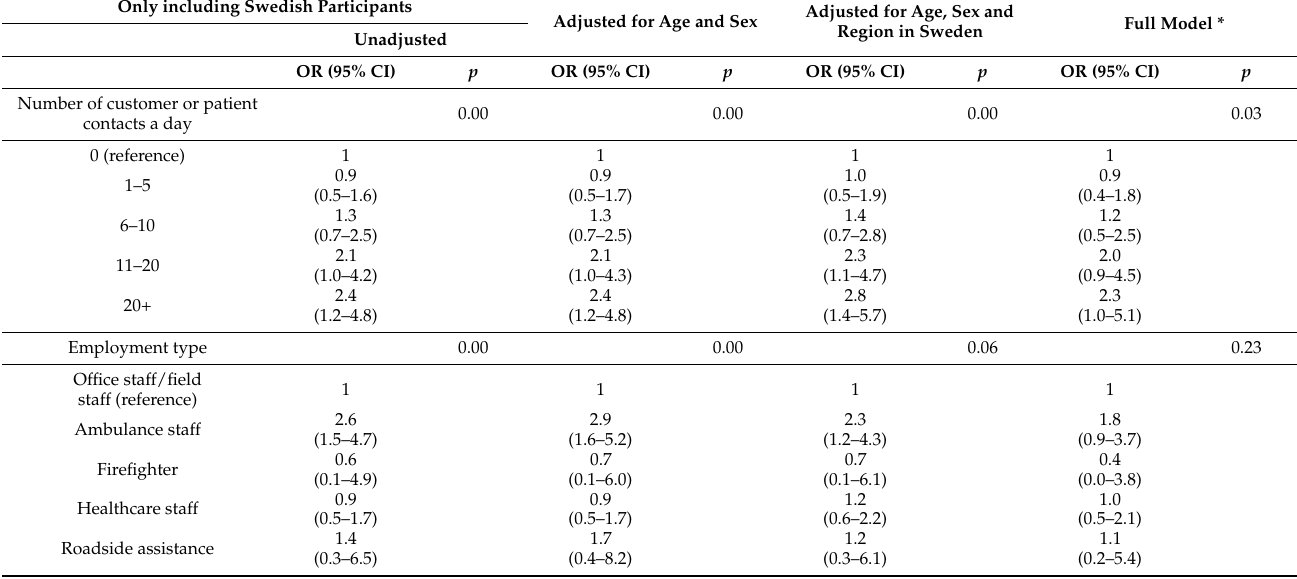
Table 4. Logistic regression of risk of positive immune COVID-19